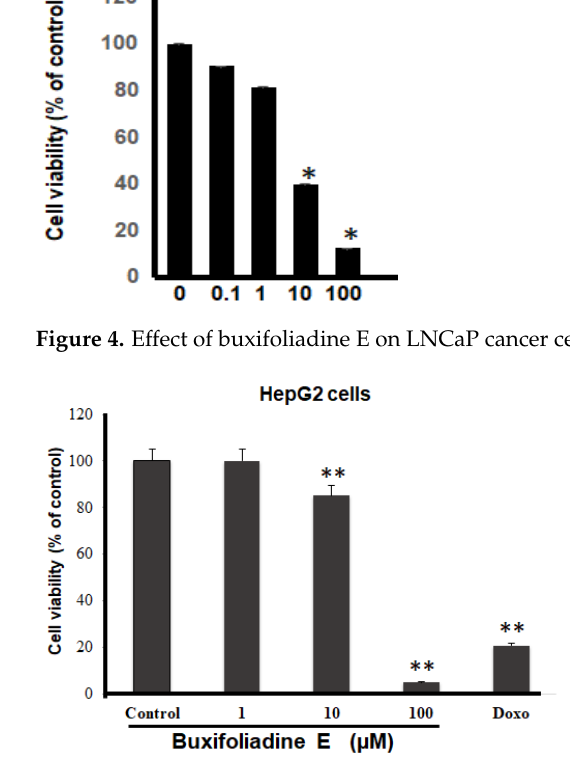
Figure 5. Effect of buxifoliadine E on HepG2 cancer cell death. ** p < 0.01.